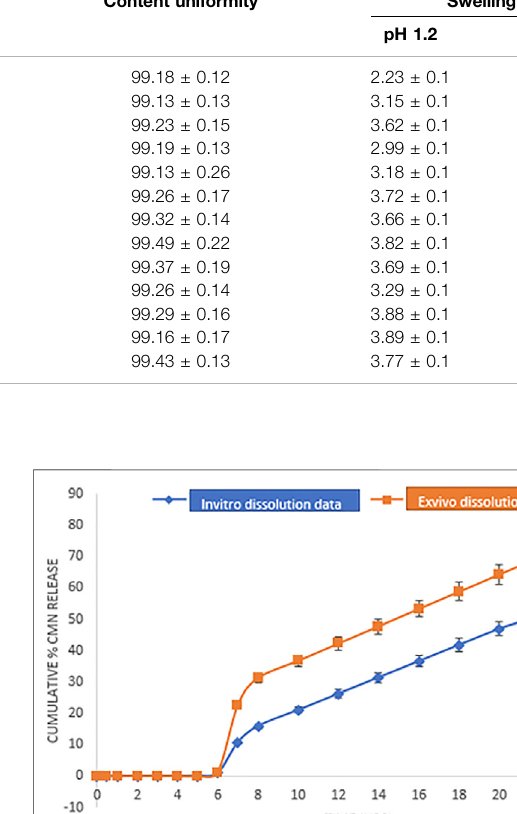
TABLE 3 | Post-compression properties of mucoadhesive tablets. Formulation